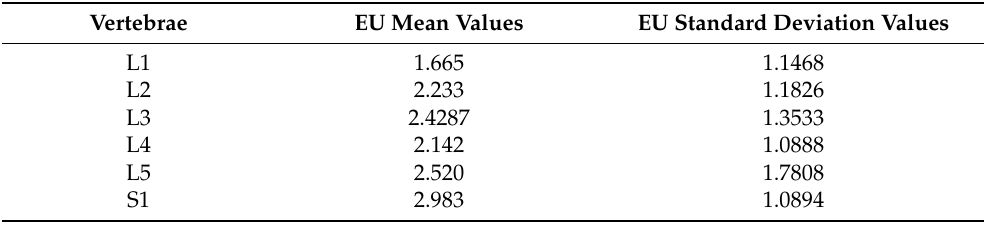
Table 1. This table represents the mean and standard deviation of EU. L1 has the lowest value of mean and L6 has the highest value of mean among all the